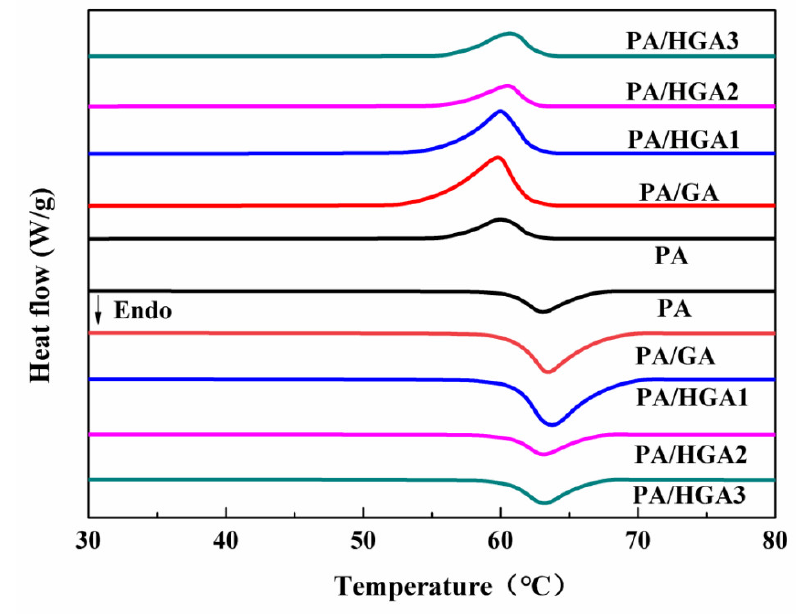
Figure 5. DSC scan of PA and PA/HGA.